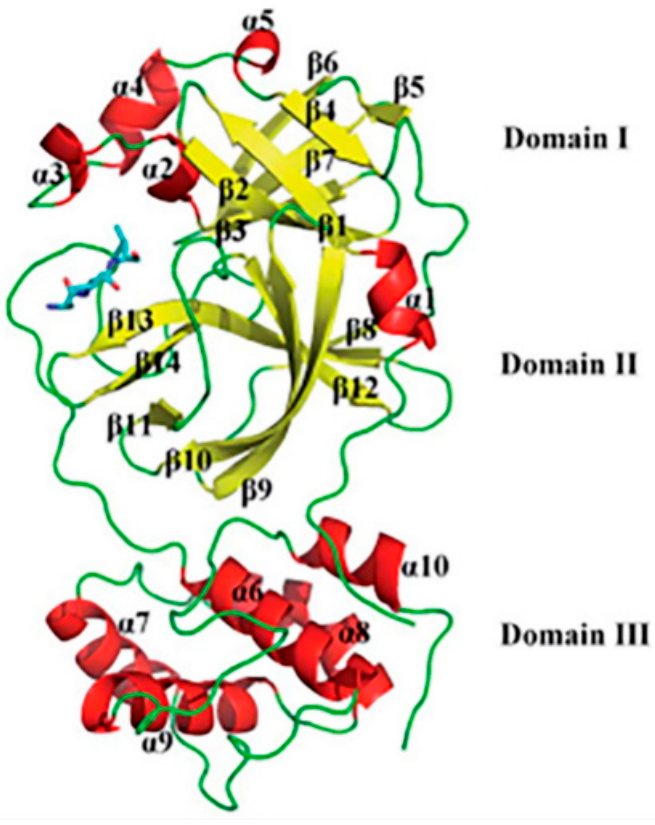
Figure 2. Three-dimensional structure of Mpro protein in complex with N3 inhibitor. It comprises three different domains.